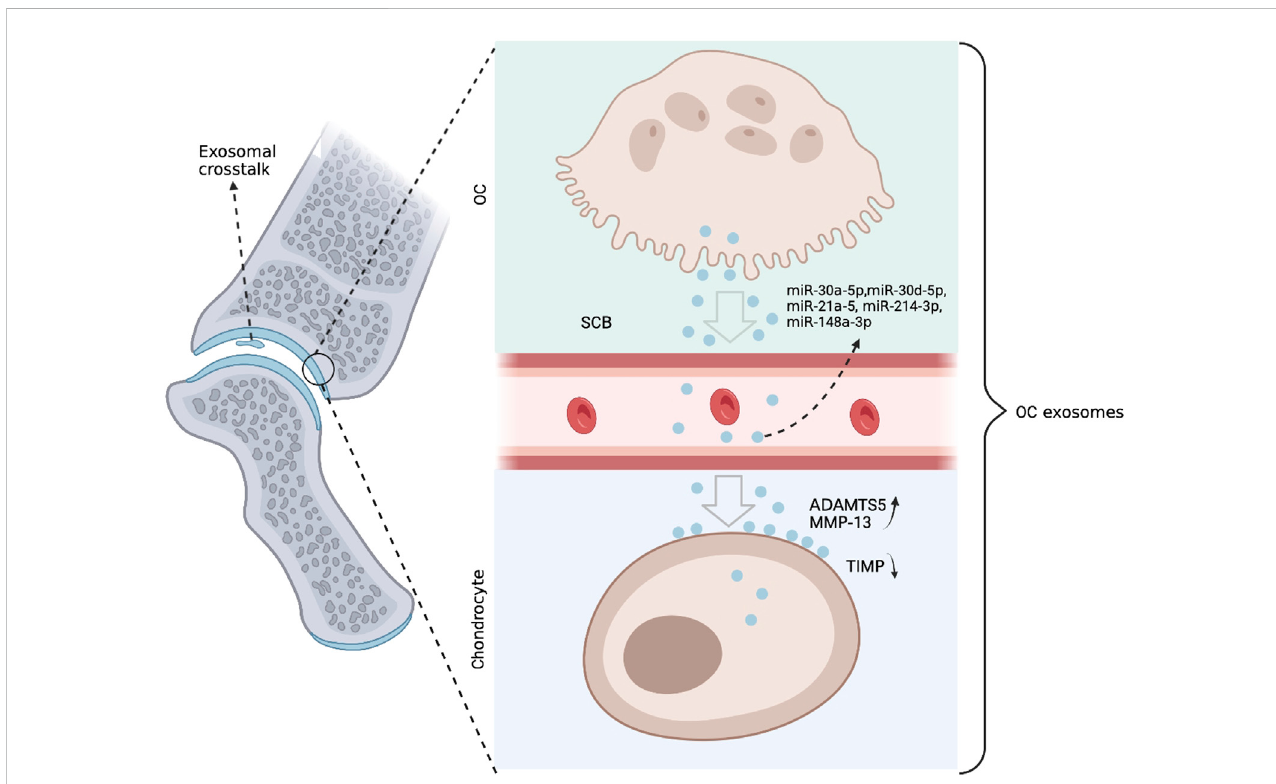
FIGURE 4 Anterior cruciate ligament transection (ACLT) was performed on mice to create the OA phenotype. Combined with in vitro culture models, small extracellular vesicles rich in coding miRNAs are secreted by OCs. These miRNAs are translocated to chondrocytes, where they suppress genes like TIMP that alleviatematrixdeterioration,increasingtheactivitiesofADAMTS5andMMP-13.TheconcentrationofOCmiRNAsincirculatingexosomesincreases,andthey appear to leave the SCB and re-enter the